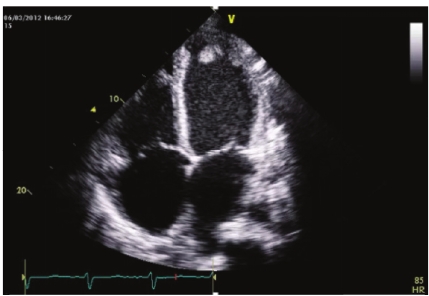
Figure 2: Transthoracic Echocardiogram (TTE). A left ventricular apical intramural thrombus can be